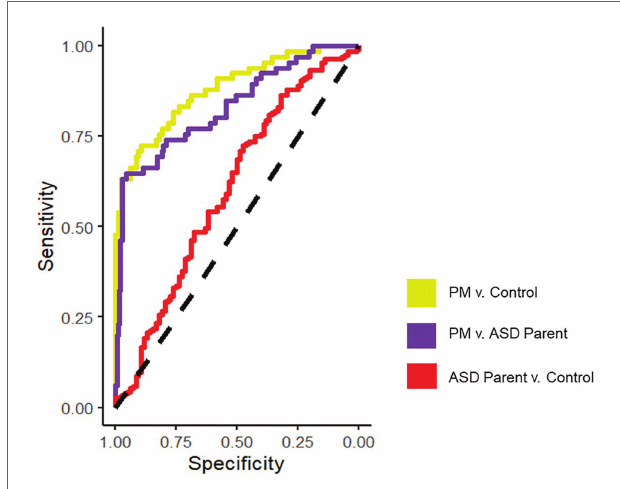
FIGURE 1 | ROC curves assessing discriminability across groups for the final logistic regression models on the averaged